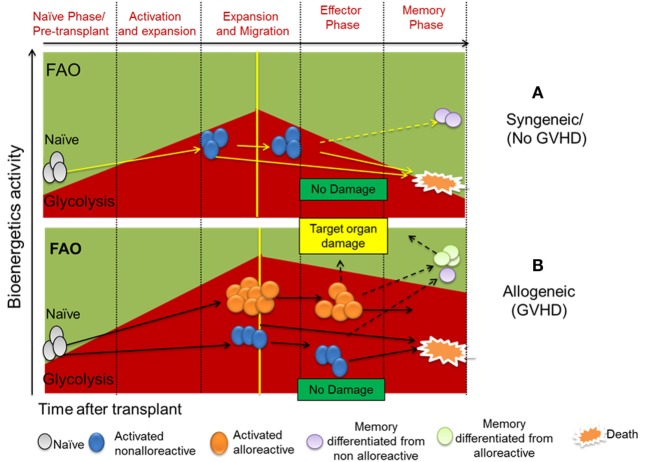
(A) Naïve/resting T cells are dependent on oxidative phosphorylation with fatty acid oxidation (FAO) as a major material resource. Upon activation by self-antigens under homeostatic state, naïve/resting T cells reprogram their metabolic phenotype to become partially activated T cells (29), which possess glycolytic metabolic phenotype. Due to lack of specific TCR stimulation, a large proportion of non-alloreactive T cells gradually die. However, specific self-epitopes of T cells can become memory T cells (Tm) which depend upon FAO for their metabolism. (B) Upon activation by alloantigen in transplant recipients, naïve/resting T cells proliferate and their memory differentiate to activate T cells both alloreactive and non-alloreactive. Alloreactive T cells and their differentiated memory cells are capable of causing target organ damage. Alloreactive T cells have much higher glycolytic activity compared to non-alloreactive counterpart. Both alloreactive and non-alloreactive T cells can die or differentiate into Tms accordingly. Glucose retention and glycolytic activity decide survival and alloreactivity of alloreactive T cells to induce graft-versus-host disease (GVHD) after allogeneic hematopoietic cell transplantation.